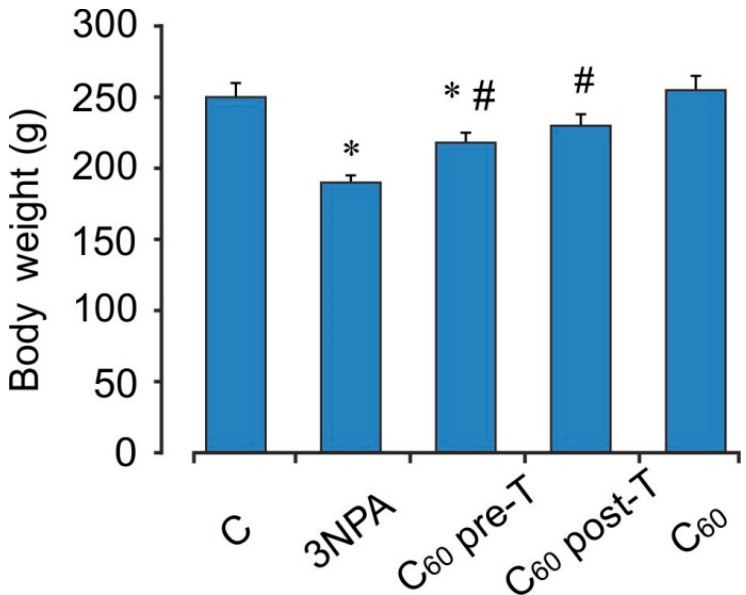
Figure 1. Effect of C 60 and 3-NPA administration on body weight rats. Values are mean ± SEM ( n = 10). The data were analyzed for statistical significance using ANOVA followed by the Bonferroni post hoc test. (C)—control; 3NPA—3-nitropropionic acid treated rats; (C 60 pre-T)—C 60 administration in pre-treatment regimen; (C 60 post-T)—C 60 administration in post-treatment regimen; (C 60 )—C 60 administration alone. * p < 0.05 vs. the control group; # p < 0.05 vs. the 3-NPA treated rats. Table 1. Effect of C 60 pre- and post-treatment on movement analysis in rats subjected to